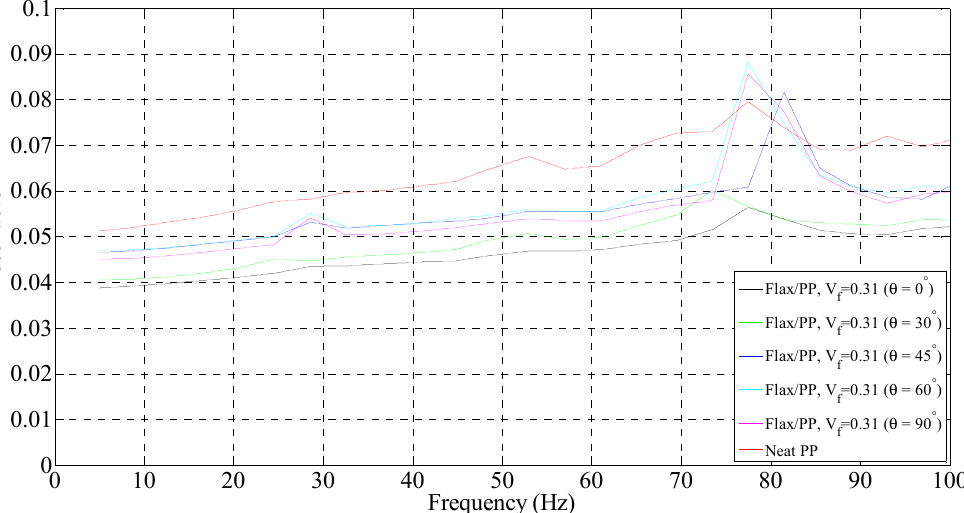
Figure 7. Loss factor of flax/PP composite samples of different fibre orientations for a fibre volume fraction of 0.31 and a neat PP sample.